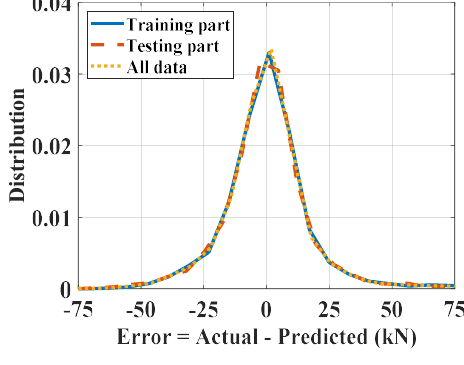
Figure 15. Distribution of errors. Table 5. Prediction capability.